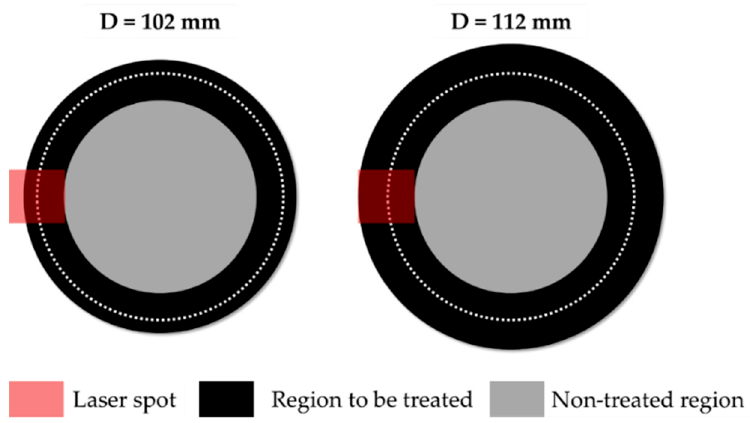
Figure 23. LHT tests. A portion of the spot irradiating the surface with the increasing blank diameter.